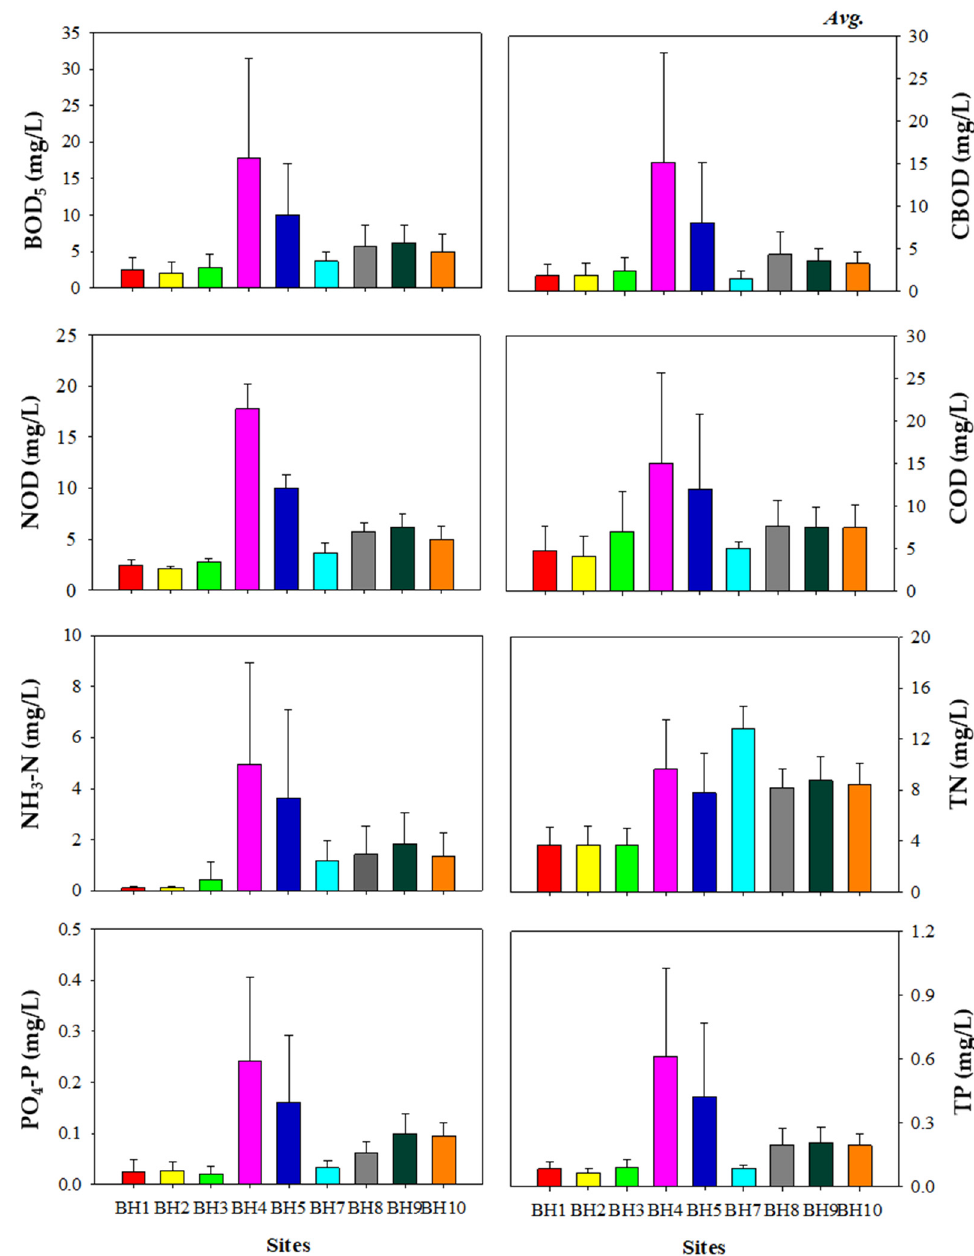
Figure 6. Average water quality parameter values of eight surveys at each river survey site.